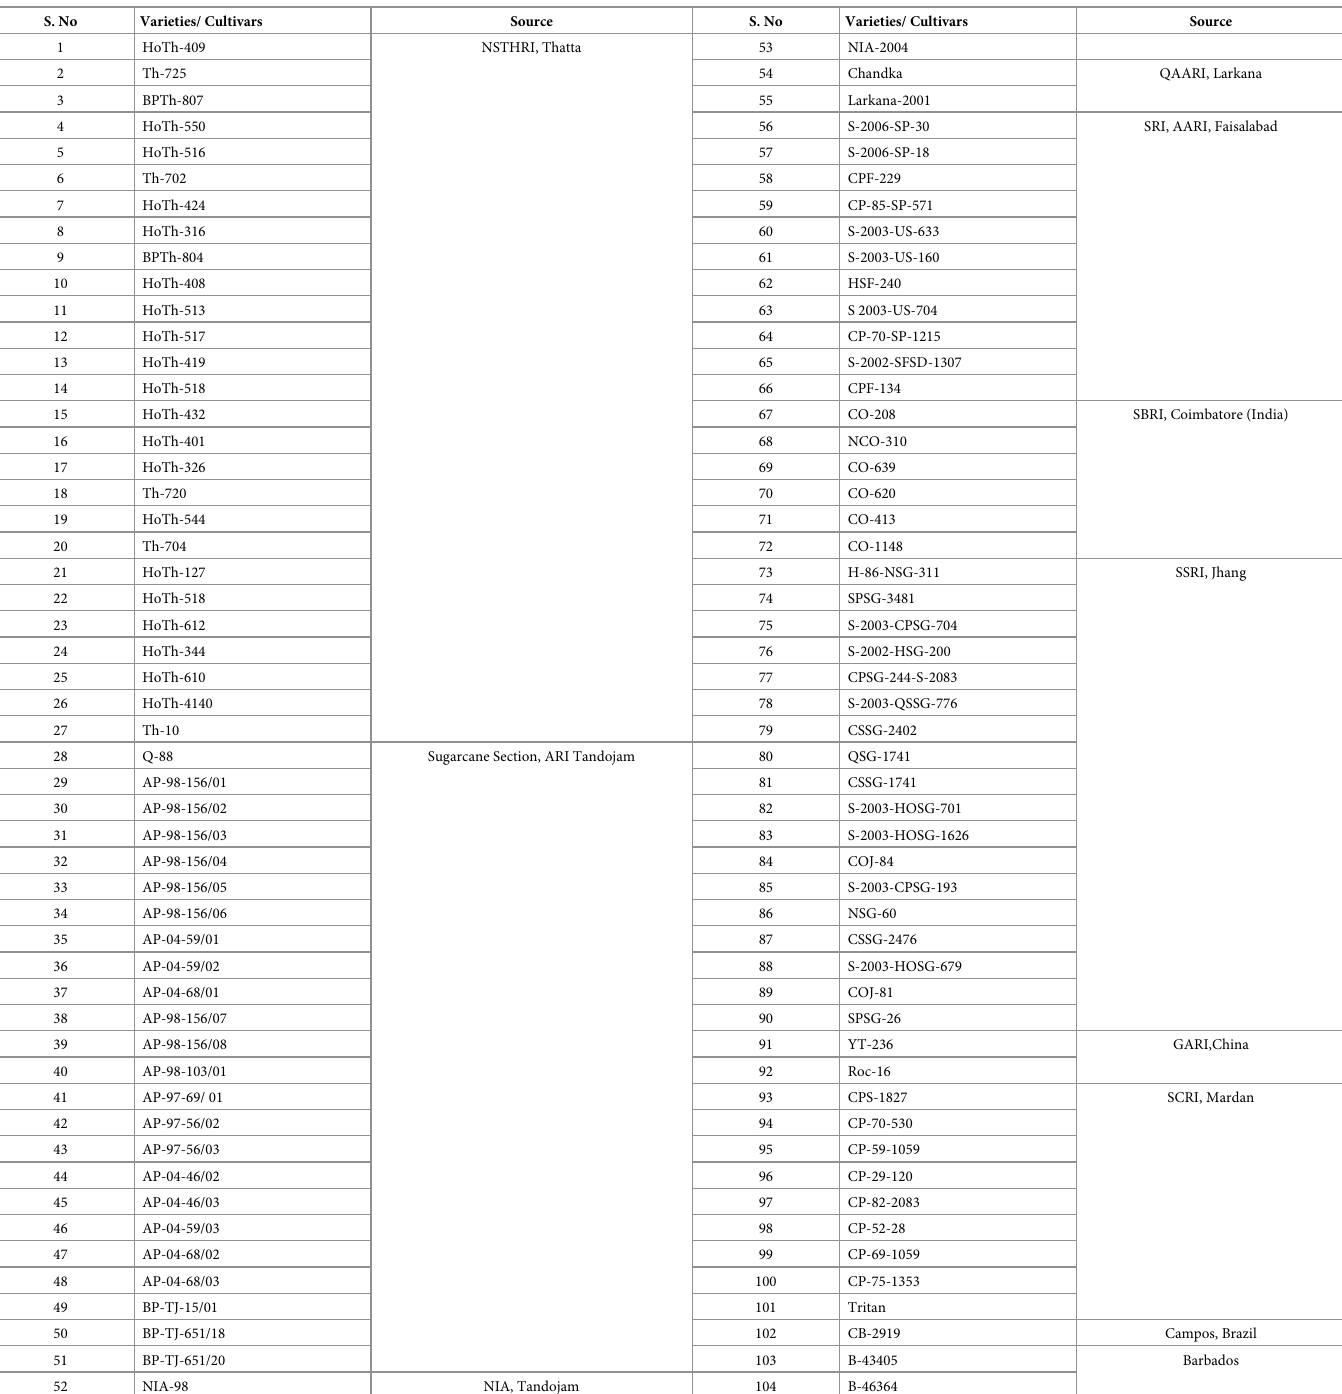
Table 1. List of cultivars grown under field conditions for two growing seasons (2014–15 and 2015–16). S.No